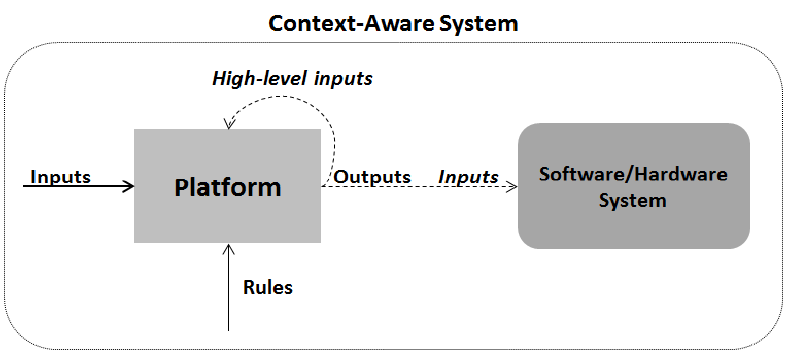
Figure 3. Context data processing pattern.